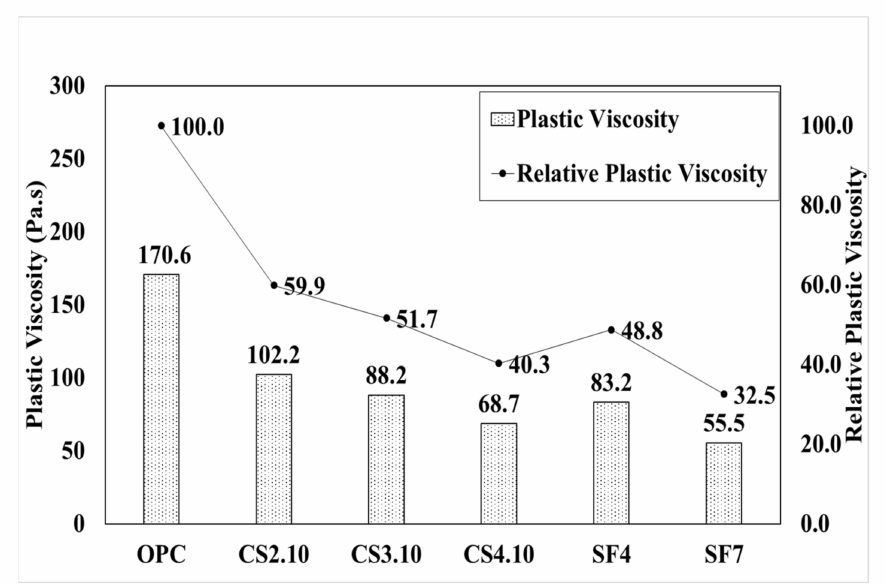
Figure 12. Plastic viscosity ( µ ) of the mixing ratio.